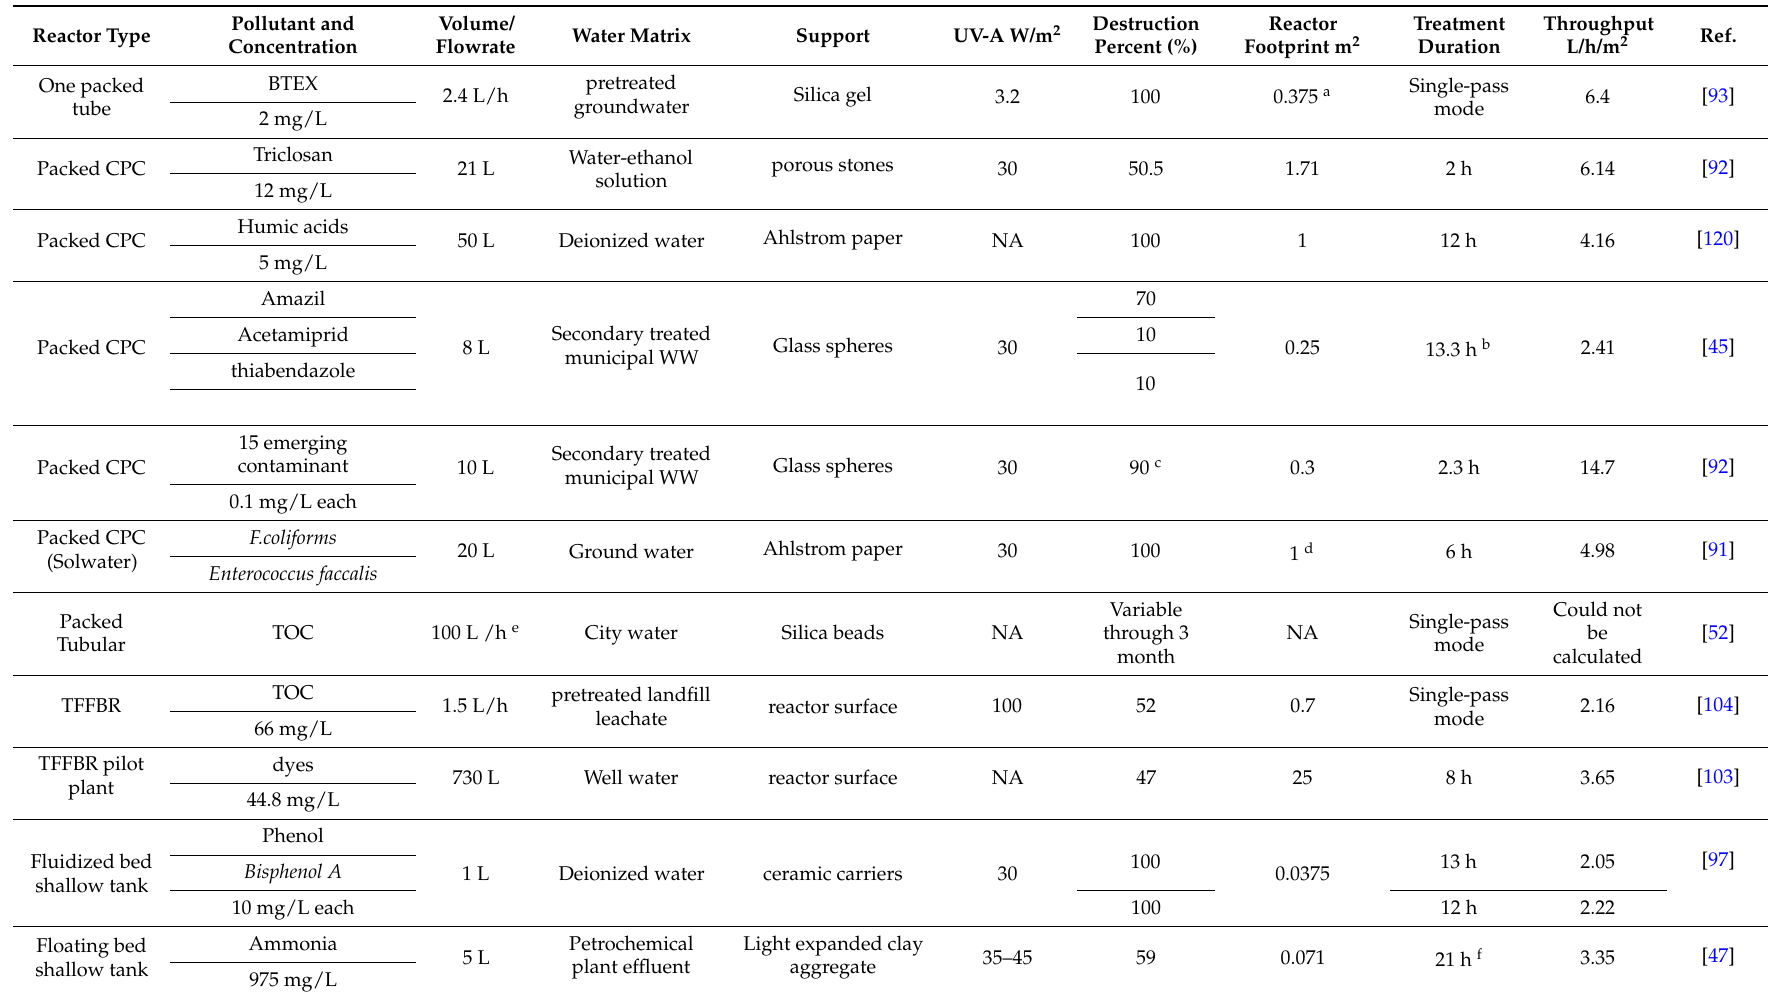
Table 3. Immobilized TiO 2 Reactors throughput and degradation